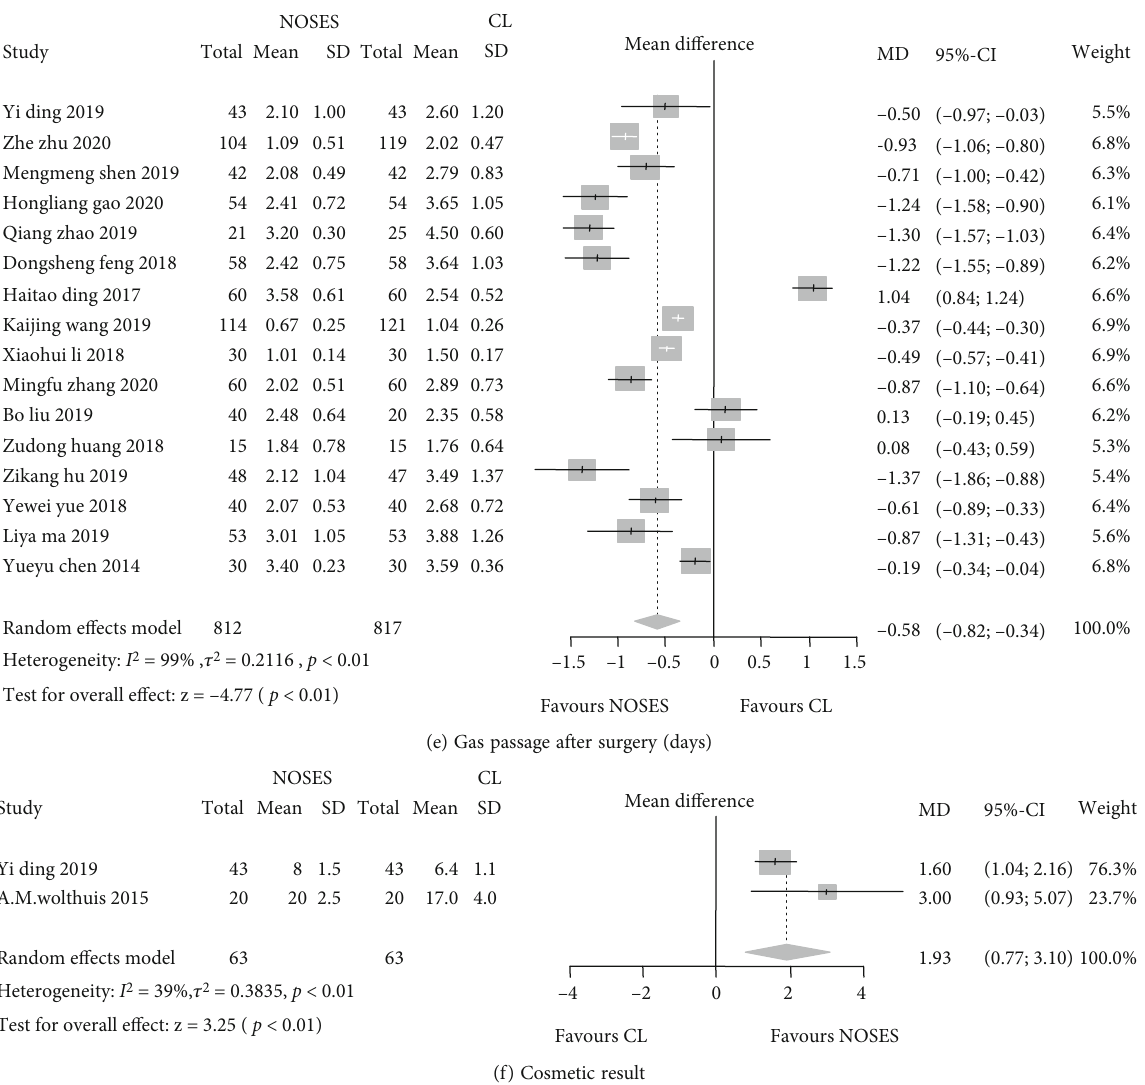
Figure 3: Forest plots of intraoperative data and postoperative recovery between the NOSE group and the CL group. (a) Operation time in minutes; (b) estimated blood loss in millilitres; (c) hospital stay after surgery in days; (d) pain score; (e) gas passage after surgery in days; (f) cosmetic